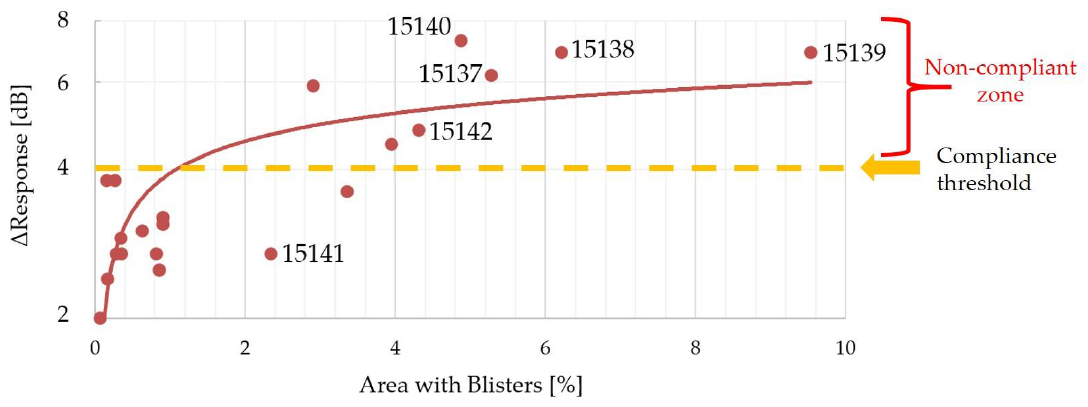
Figure 14. ΔResponse versus area with voids or blisters.